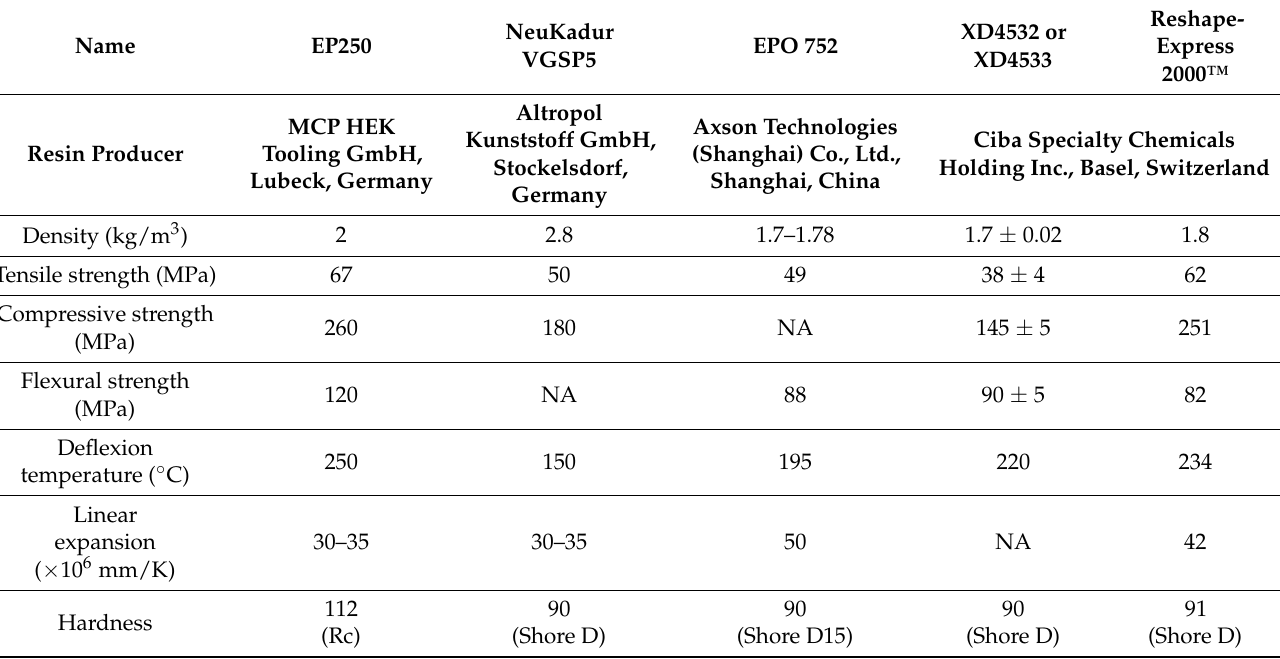
Table 4. Different types of resin and their properties